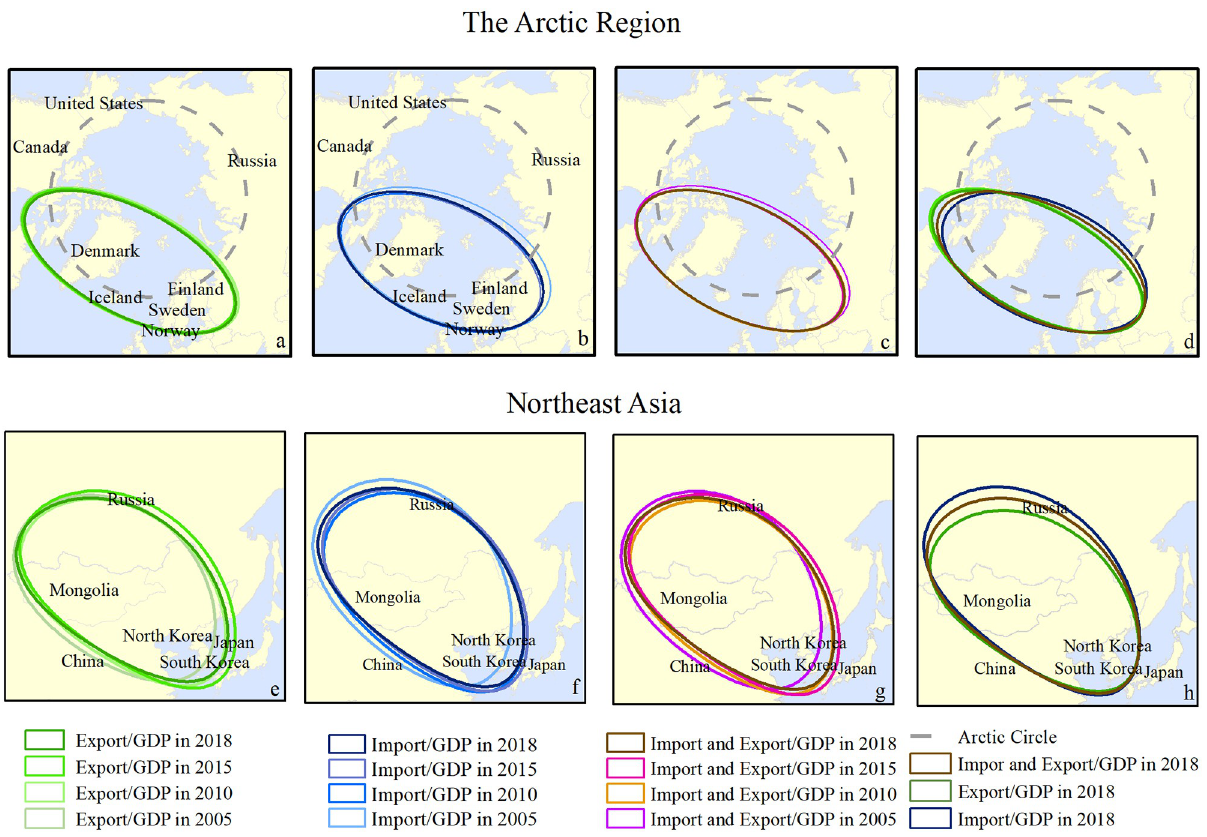
Fig 8. Movement of the standard deviational ellipse and centroid of foreign trade indicators in the Arctic region and Northeast Asia. The boundary was obtained from Natural Earth (http://www.naturalearthdata.com/).